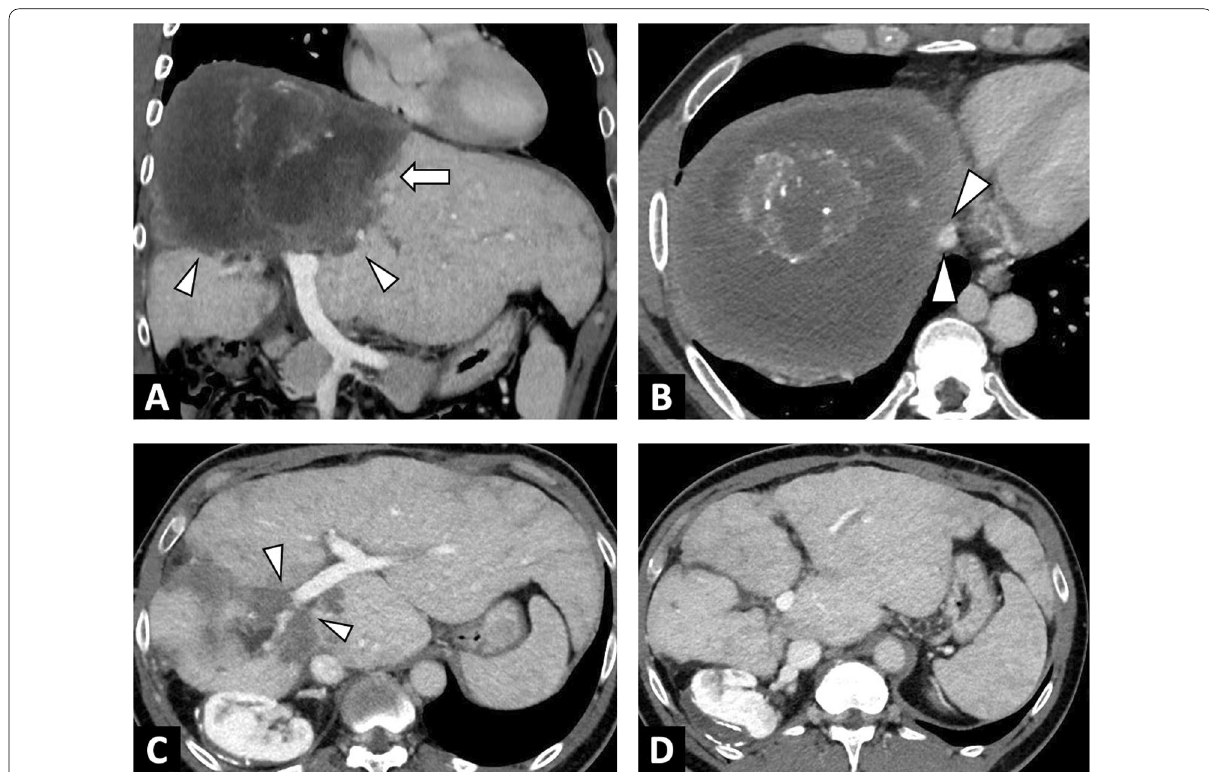
Fig. 11 Alveolar echinococcosis lesion of the right liver in a 44‑year‑old man complicated by advanced chronic liver disease secondary to Budd Chiari syndrome. A CT image in the coronal plane at the portal phase showing alveolar echinococcosis of the right liver (arrow) associated with infiltration to the pedicle (arrowheads). B CT image in the axial plane obtained during the portal phase: invasion of the inferior vena cava and the ostium of the hepatic veins (arrowheads). C CT image in the axial plane obtained during the portal phase: infiltration of the right liver pedicle (arrowheads) D. Hypertrophy of the left liver lobe and surface nodularity suggestive of advanced fibrosis. Note the mosaic pattern of enhancement, sign of hepatic sinusoidal dilatation, as a result of the Budd Chari